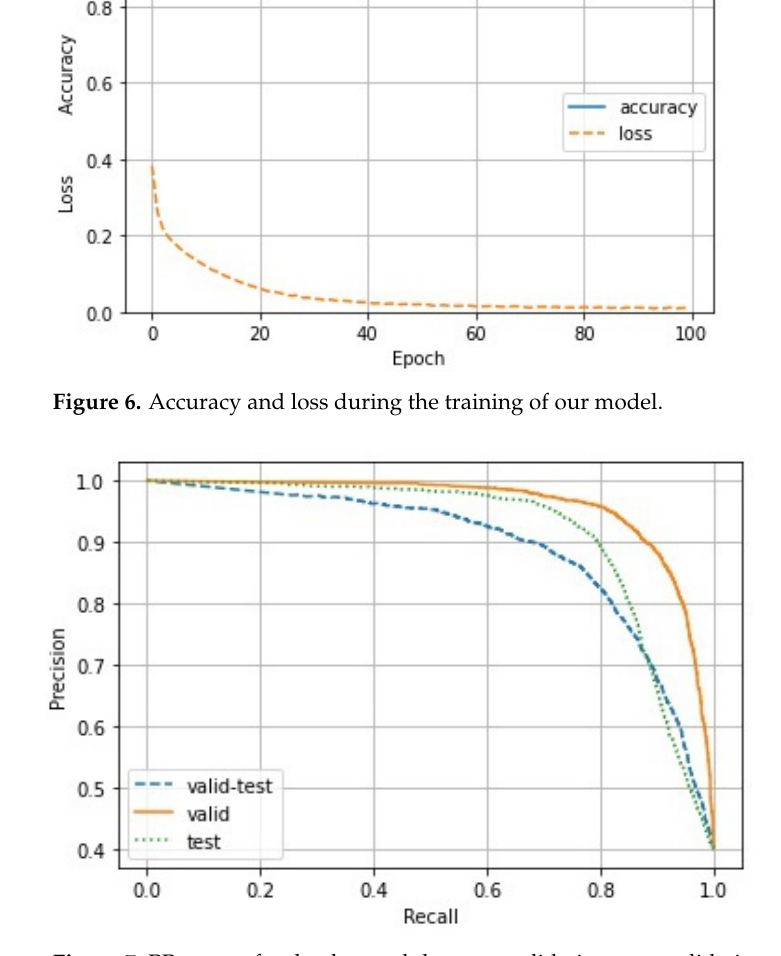
Figure 7. PR curves for the three subdatasets, validation–test, validation, and